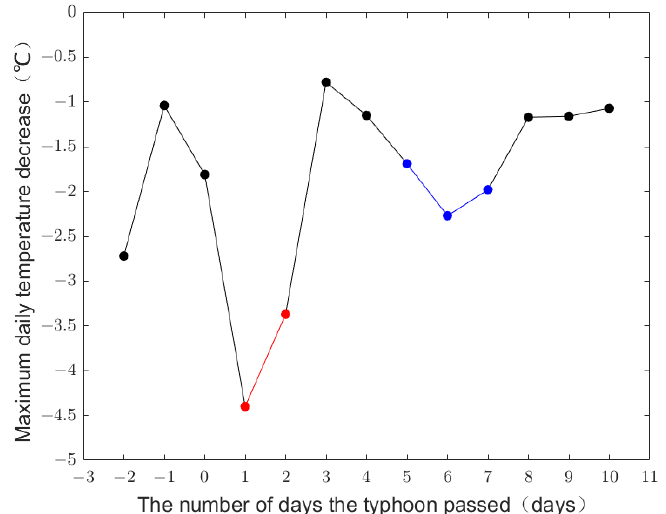
Figure 5. The maximum decrease in SST during the passage of the typhoon (Black represents when no typhoon passed, red represents when Nasat passed by, and blue represents when Nalgae passed by ).